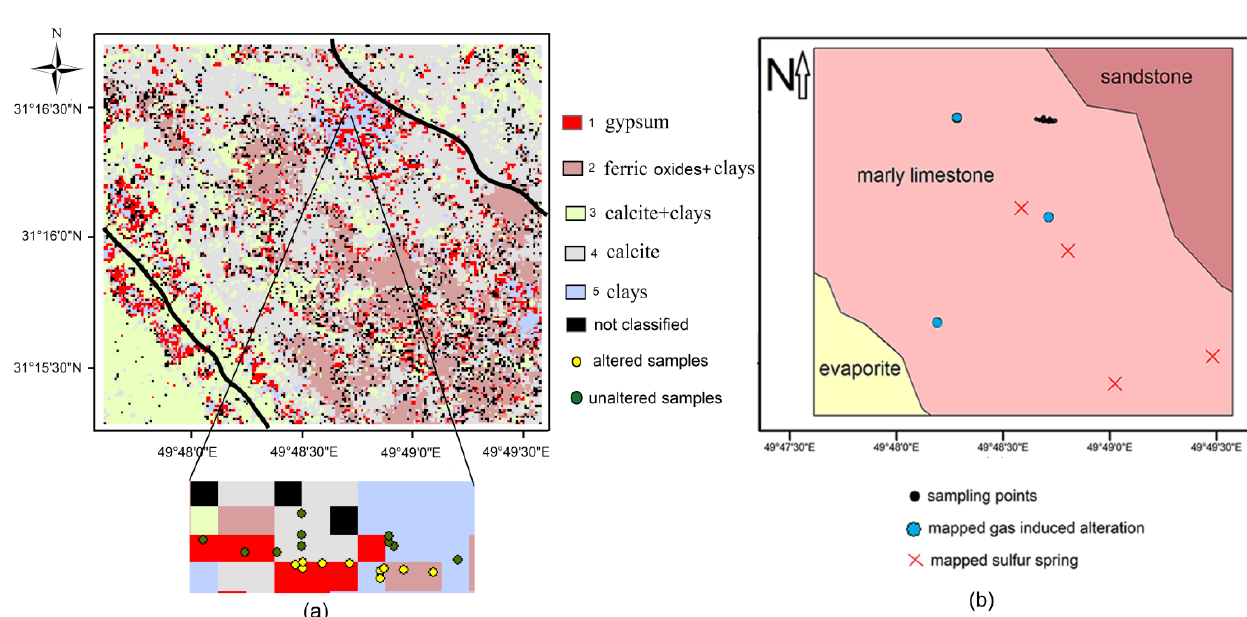
Figure 9. Results obtained by the boosted regression trees (BRT) classification with end-members extracted from the purest image pixels of